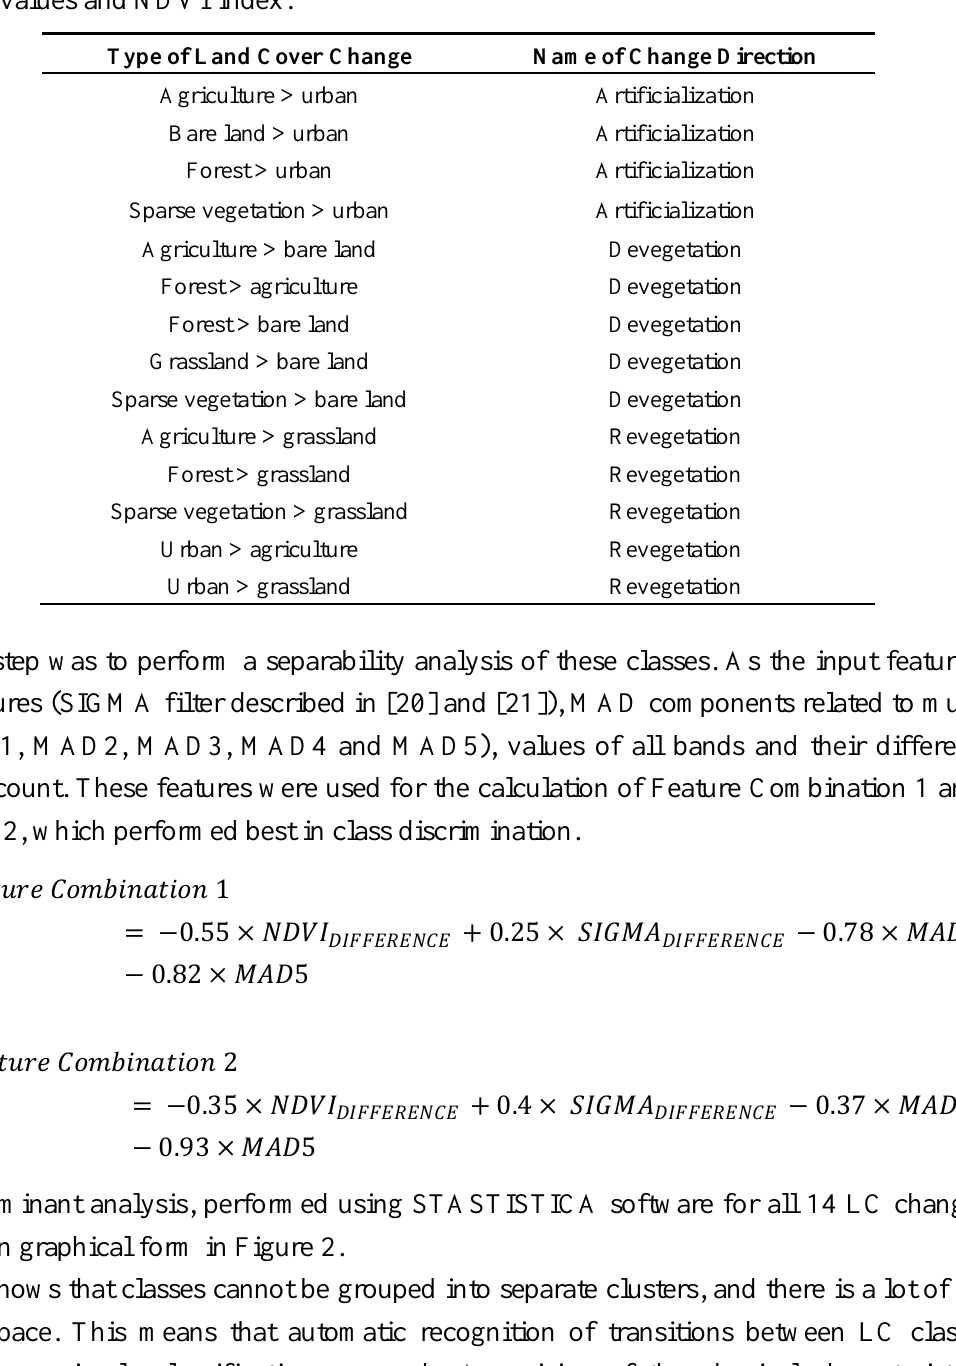
Table 2. Land cover changes and the direction of the change based on differences in texture values and NDVI